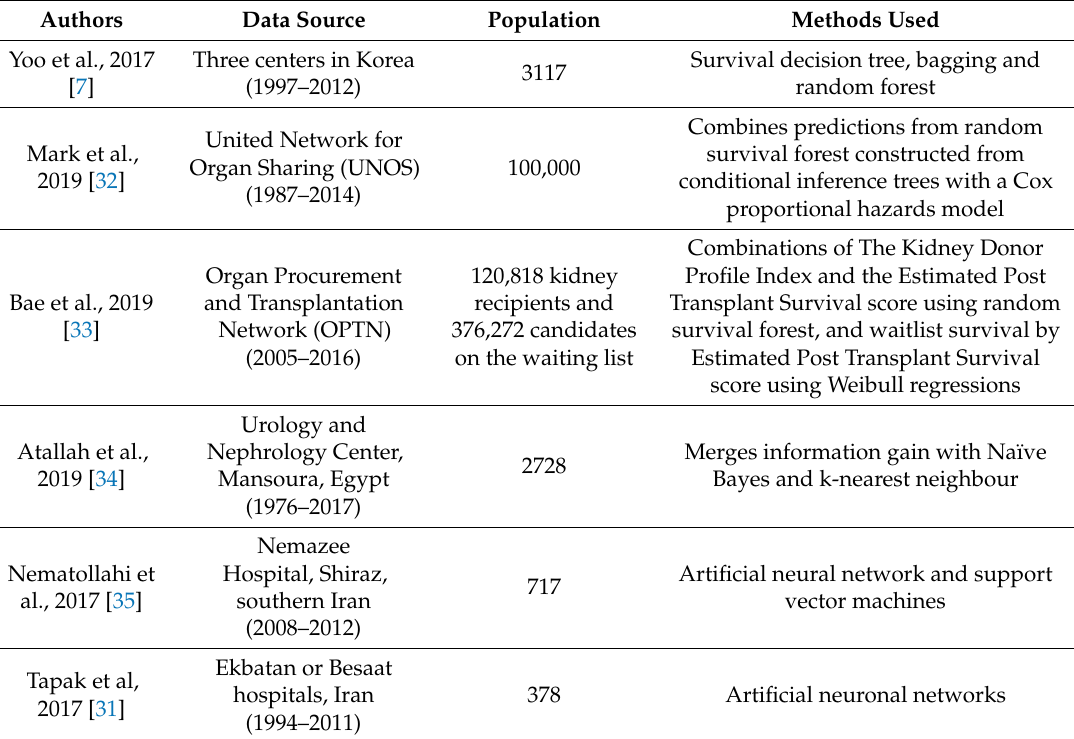
Table 1. Papers analysed in this